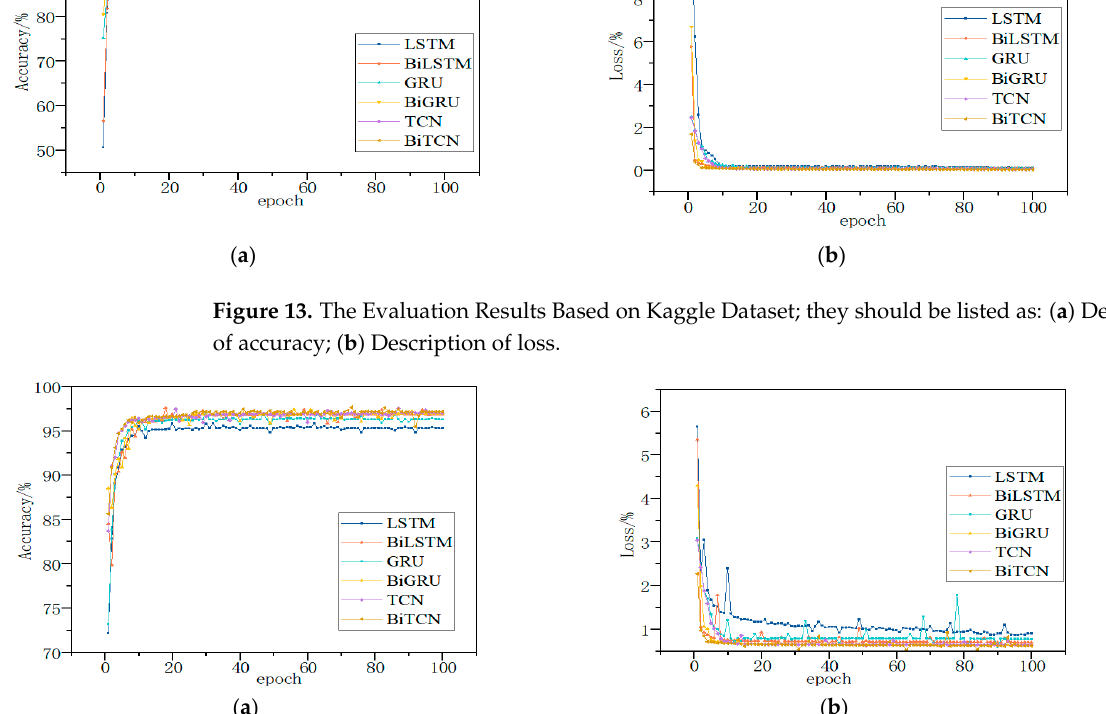
Table 11. Detection accuracy under the influence of difference algorithms on Kaggle